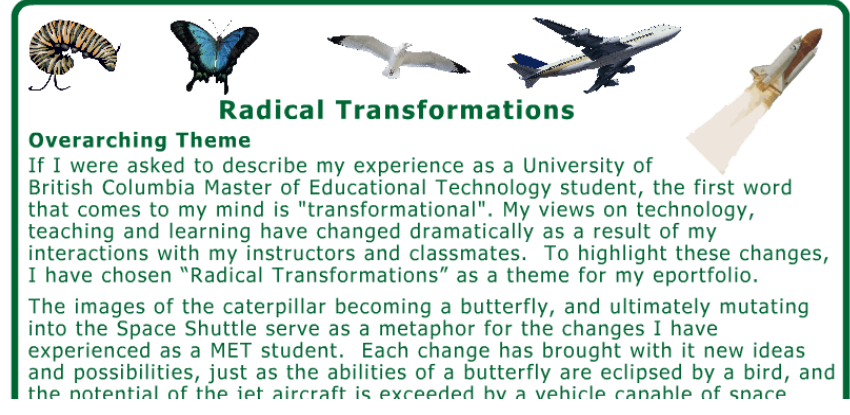
Figure 1. Visual representation of transformation (Monte’s ePortfolio)